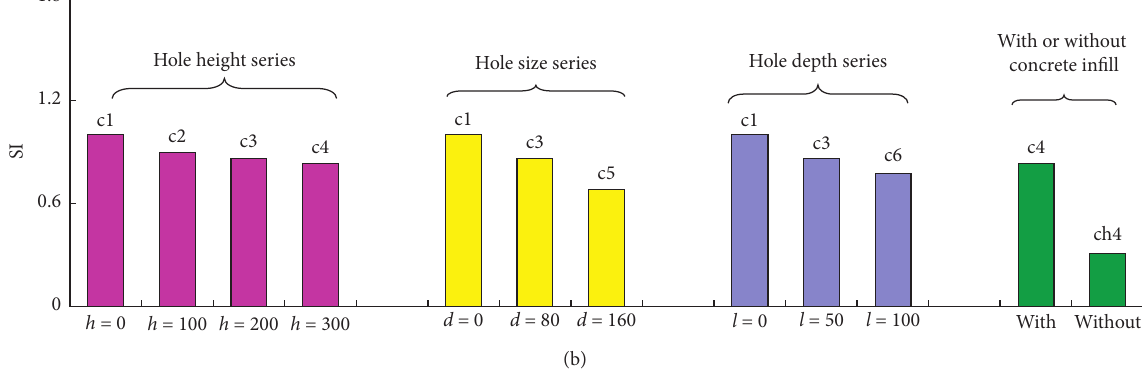
Figure 10: Strength index (SI) of opening CFST columns. (a) Square section. (b) Circular section.